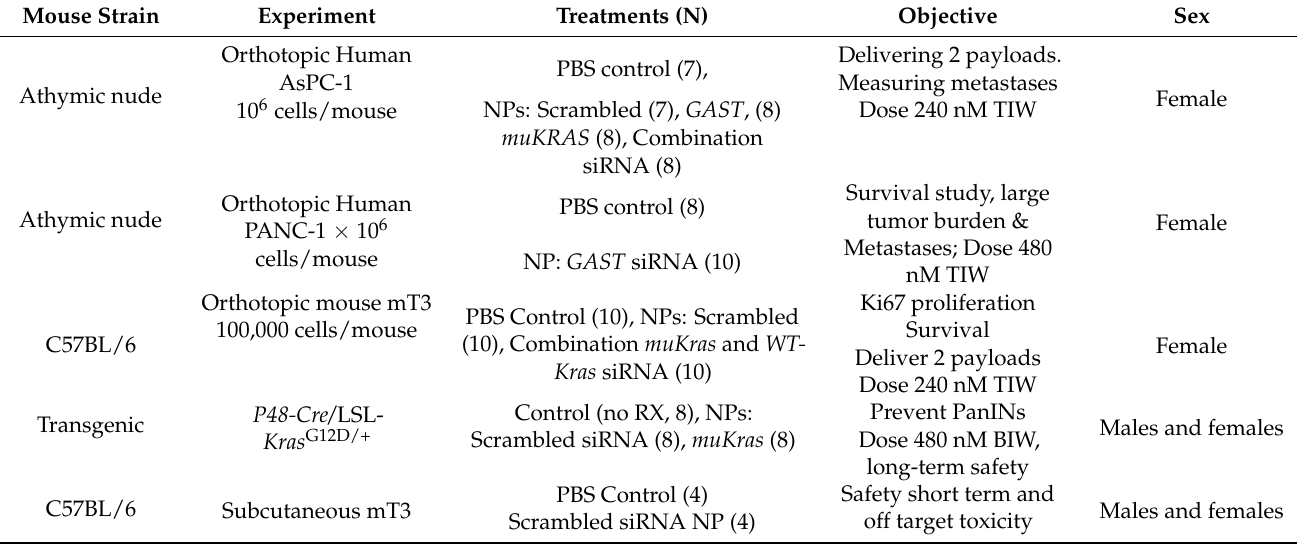
Table 2. Experimental design of five separate in vivo